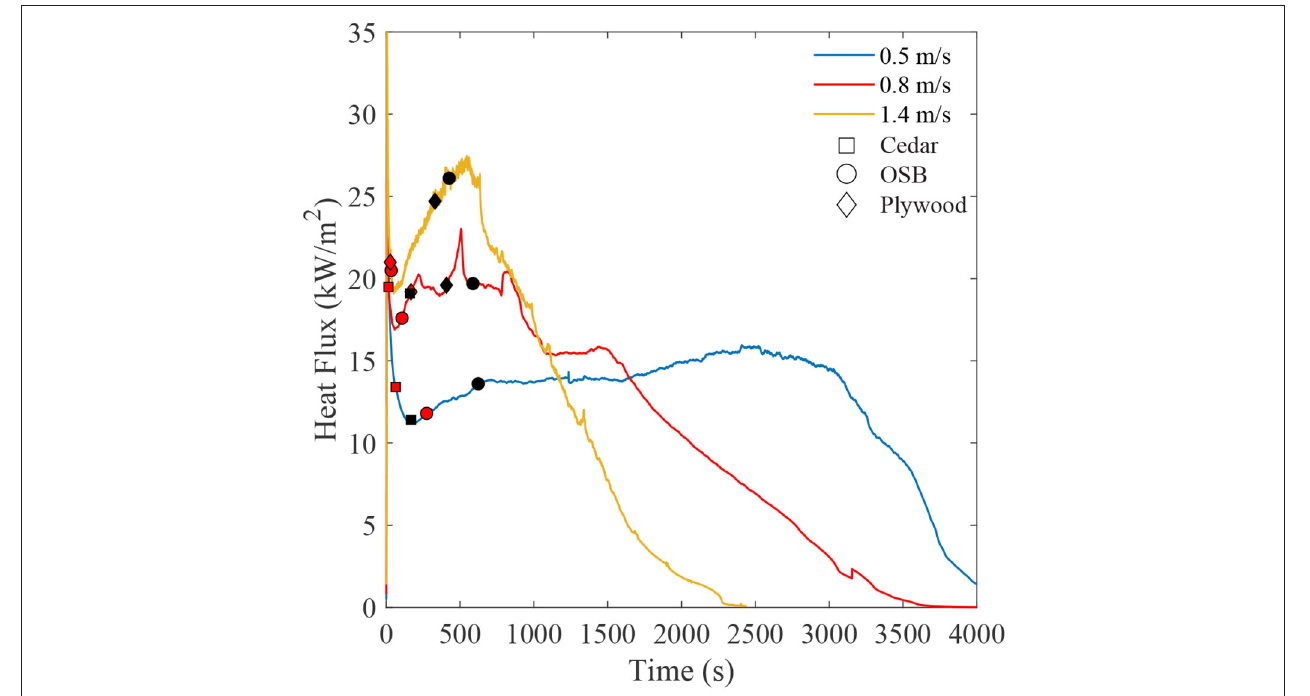
FIGURE 10 | Averaged heat flux curves for inert tests under three wind speeds and a 16 g firebrand pile. Time of flaming (red) or smoldering (black) ignition is marked on the heat flux curves for three fuels, cedar, OSB, and